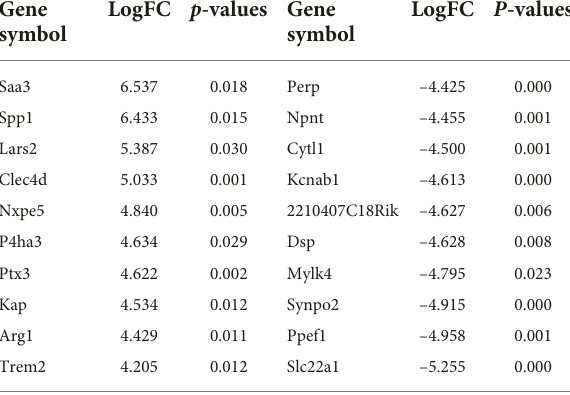
TABLE 1 The top 10 upregulated and downregulated genes of DEmRNAs.